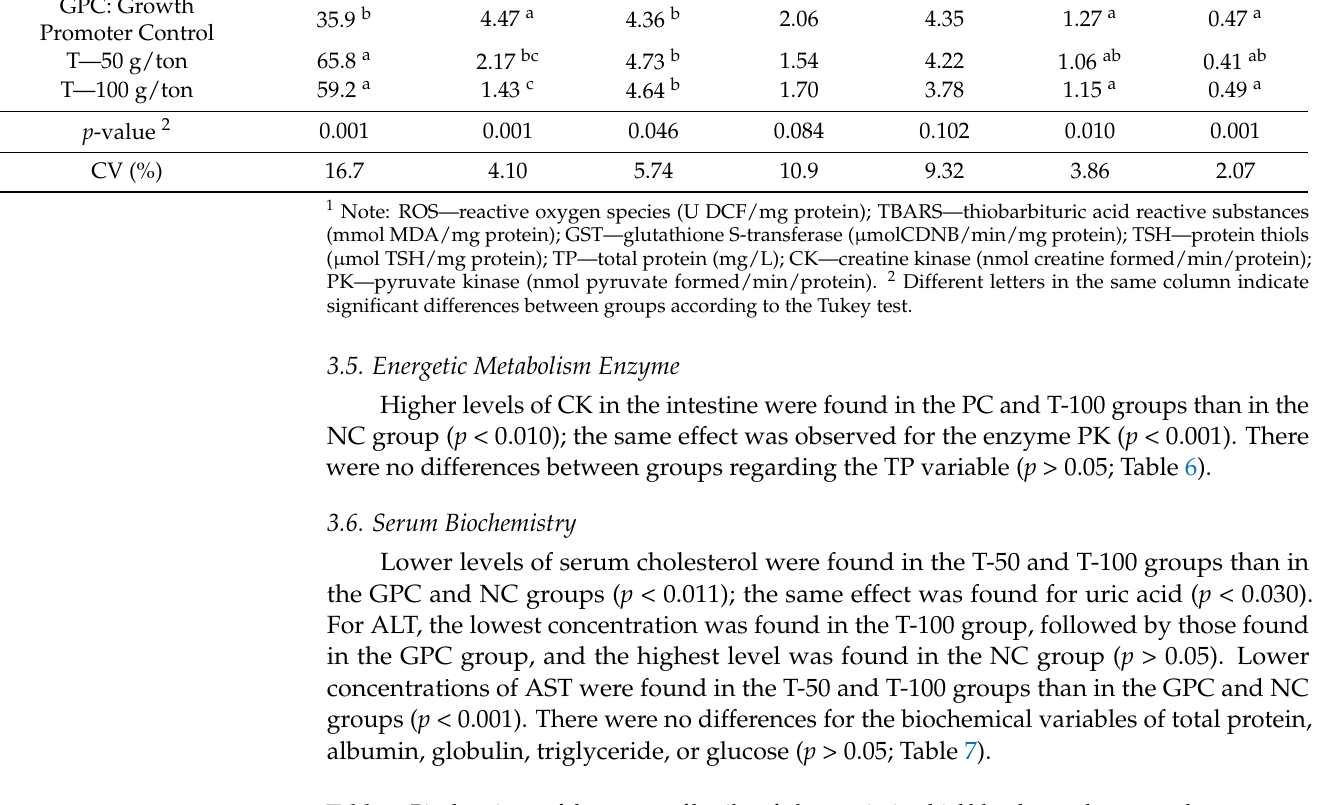
Table 7. Biochemistry of the serum of broilers fed an antimicrobial blend to replace growth